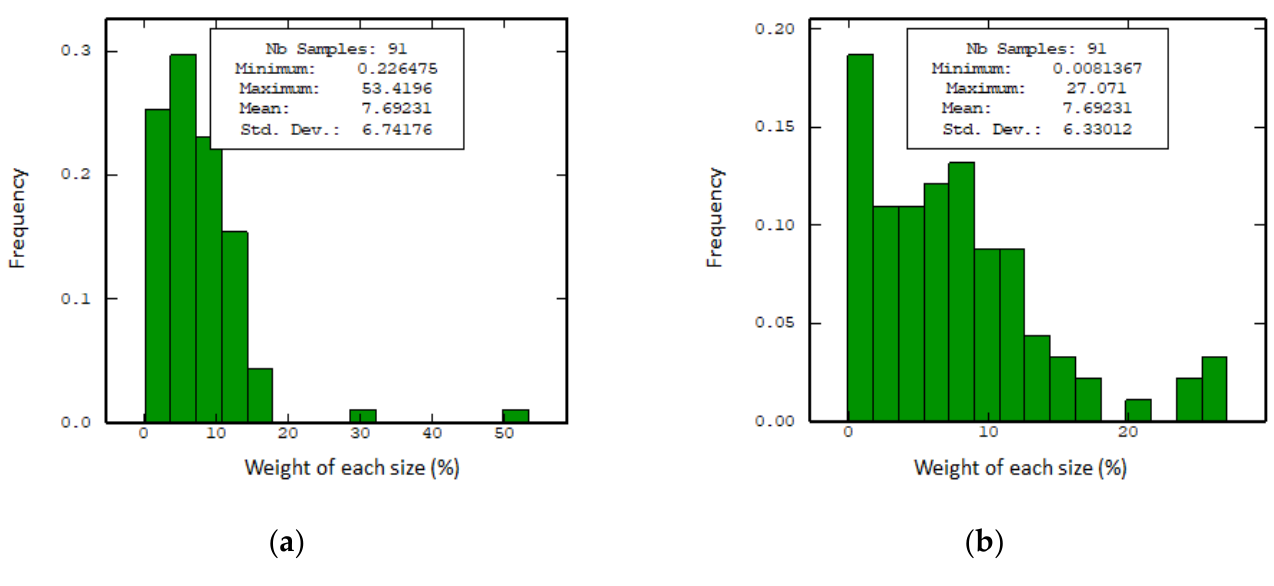
Figure 4. Histogram of the input data using LGP-1: ( a ) Ore-A and ( b ) ore-B.